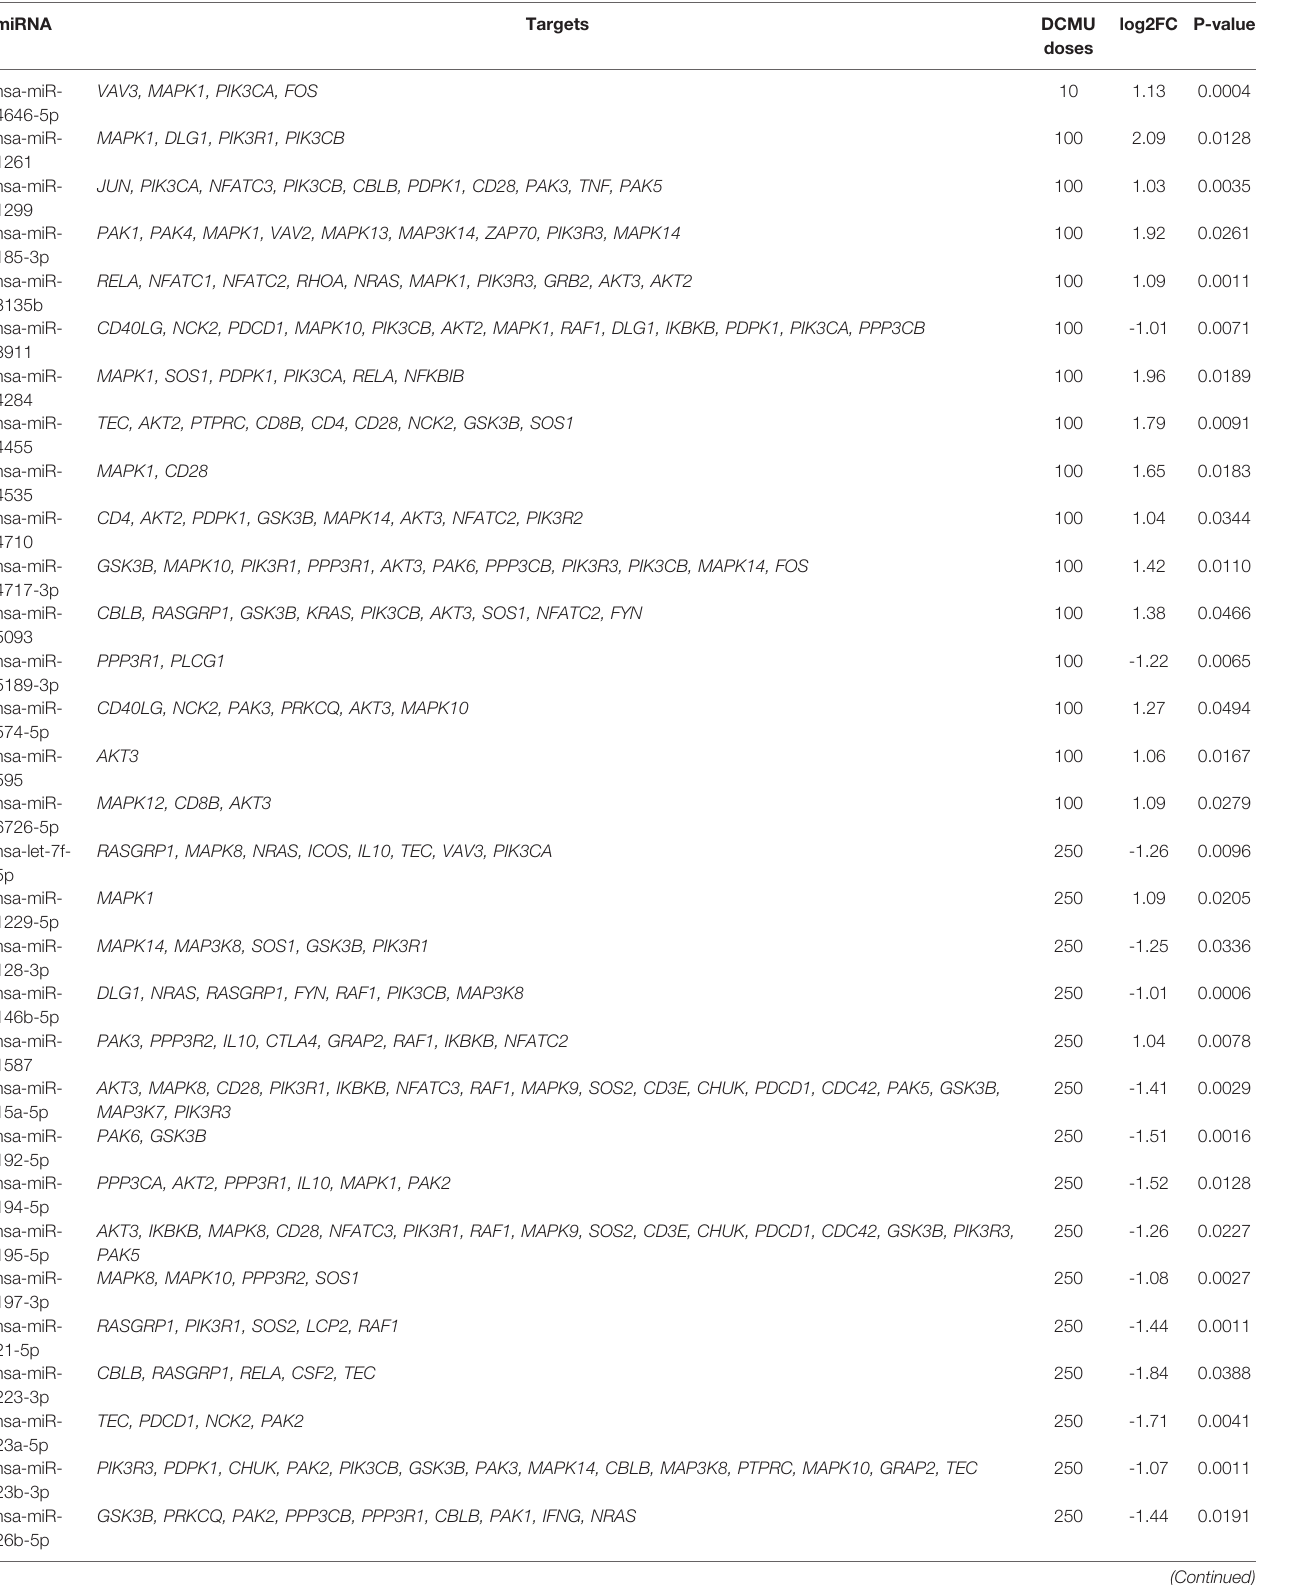
TABLE 1 | List of candidate miRNAs based on the target prediction analysis.